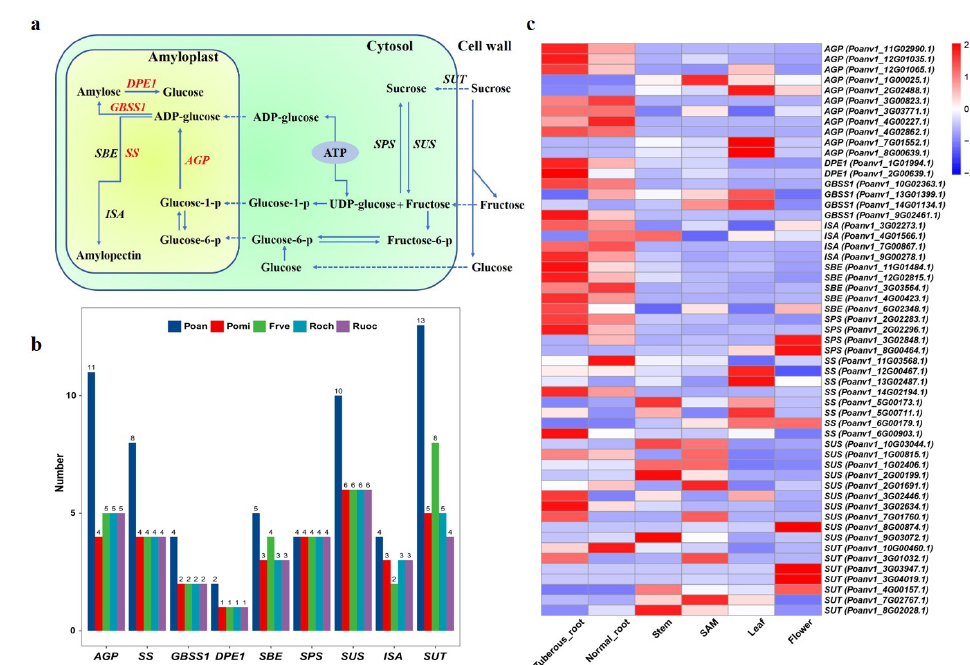
Figure 5. Analysis of key genes involved in starch metabolism. ( a ) A diagram depicting the main reactions involved starch metabolism. ( b ) Key gene copy numbers among Poan, Pomi, Frve, Roch, and Ruoc. ( c ) Heatmap of the expression level of genes related in starch metabolism in different